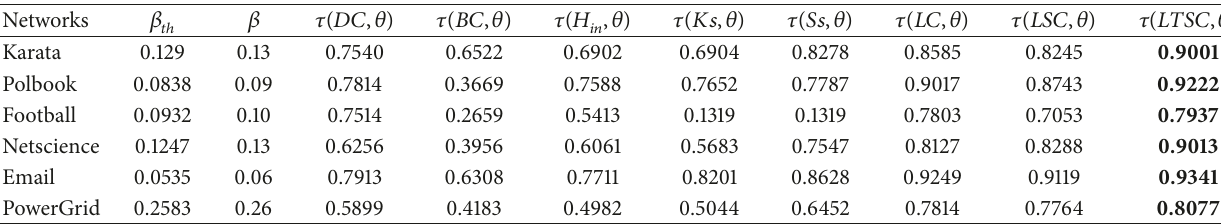
Table 4: Kendall’s 𝜏